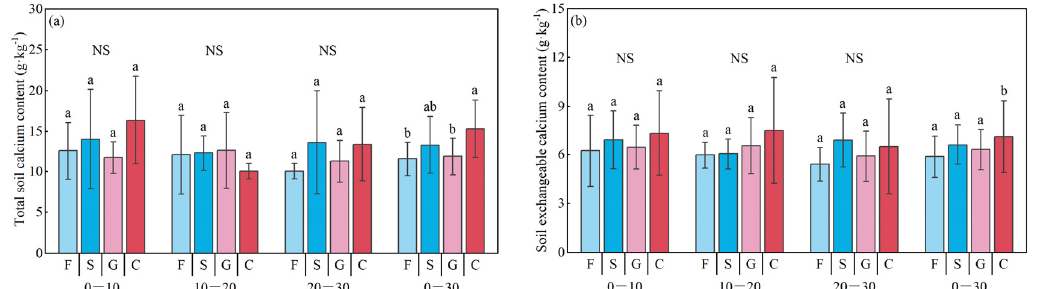
Figure 4. Total soil calcium content of different vegetation types ( a ); Soil exchangeable calcium content of different vegetation types ( b ). Different lowercase letters represent significant differences in soil calcium content between vegetation types ( p < 0.05); F: forest; S: scrub; G: grassland; C: crops.